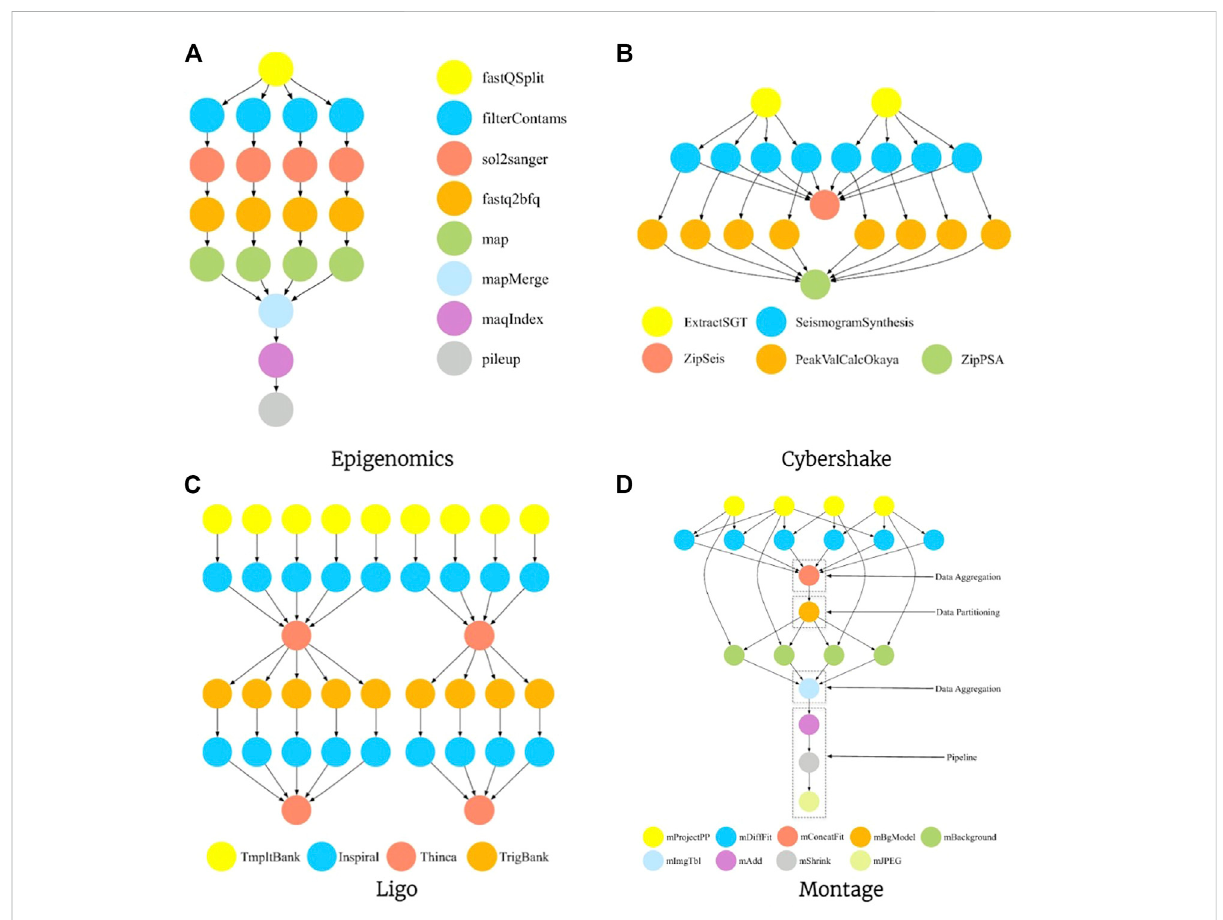
FIGURE 7 The structures of four classes of scienti fi c work fl ow.